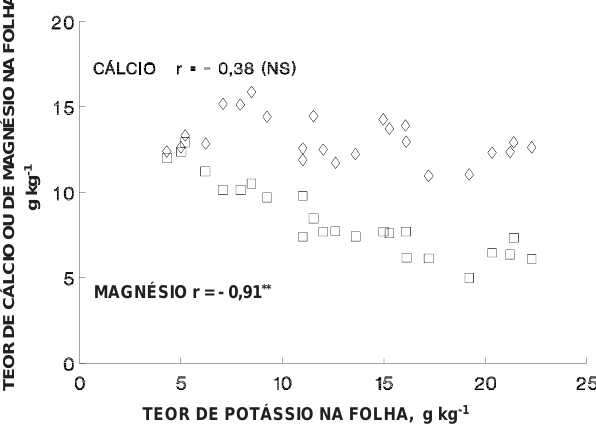
Figura 4. Relações entre os teores de cálcio ou de magnésio e os de potássio no tecido foliar de soja. Resultado de quatro safras. Média de três repetições.